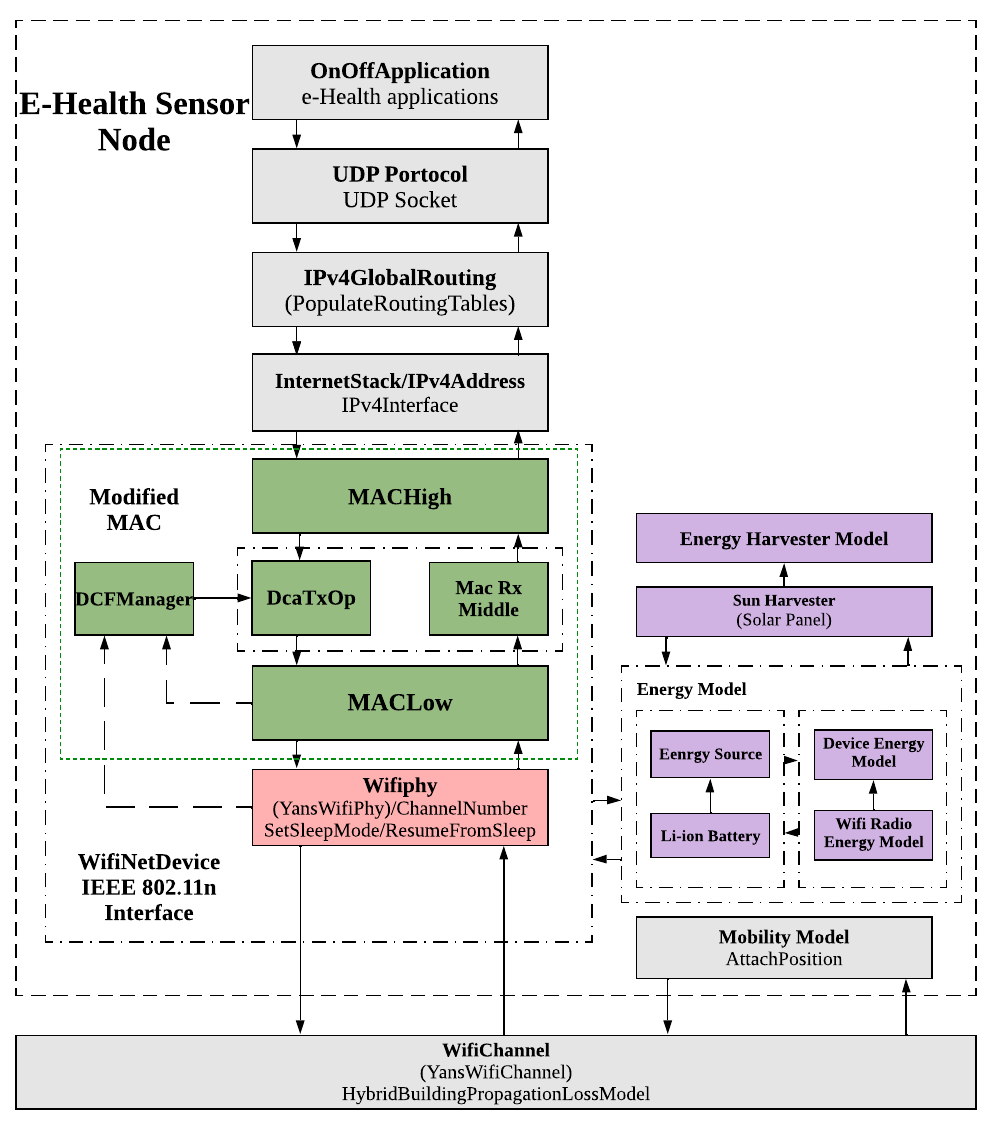
Figure 8. The layered structure of a sensor node (The modules in green, pink and purple represent the modified MAC layer, PHY layer, energy model, and energy harvester,